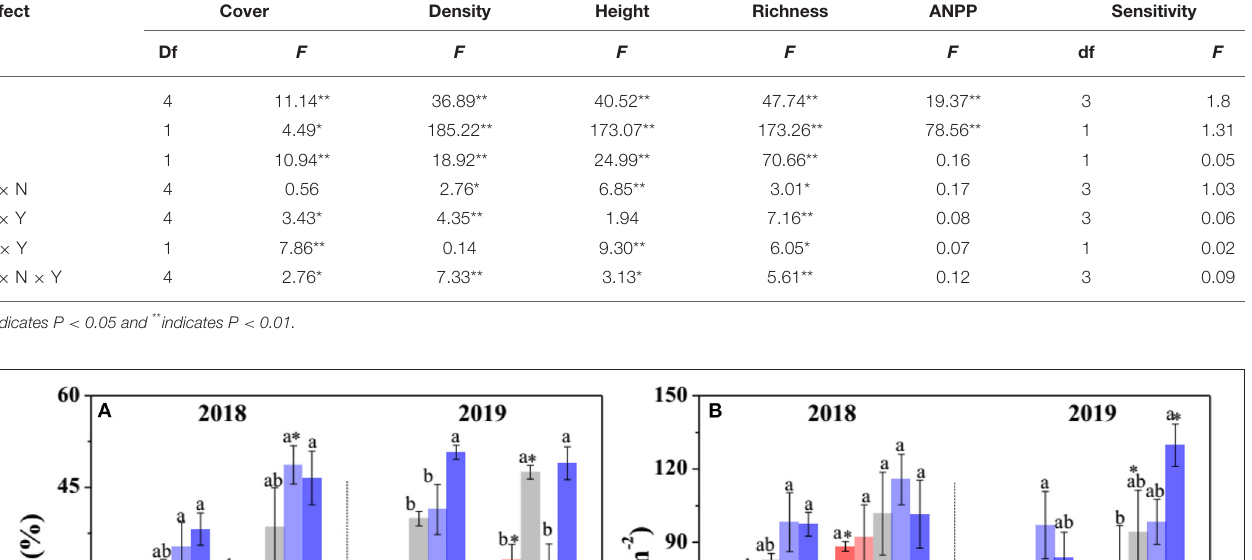
TABLE 1 | GLMM results for the effects of precipitation change (P), nitrogen application (N), year (Y), and their interactive effects on ANPP, the sensitivity of ANPP (Sensitivity) and community attributes. Effect Cover Density Height Richness ANPP Sensitivity